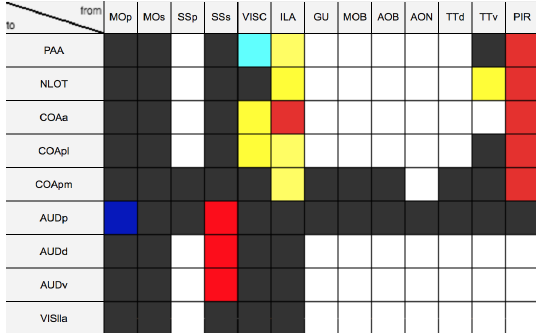
Figure 8. Interactive matrix from Brain Architecture Management System (BAMS). Each element of the matrix represents the connection between two regions, reported in rows and columns. Different colours encode different connection intensities, with white corresponding to unknown